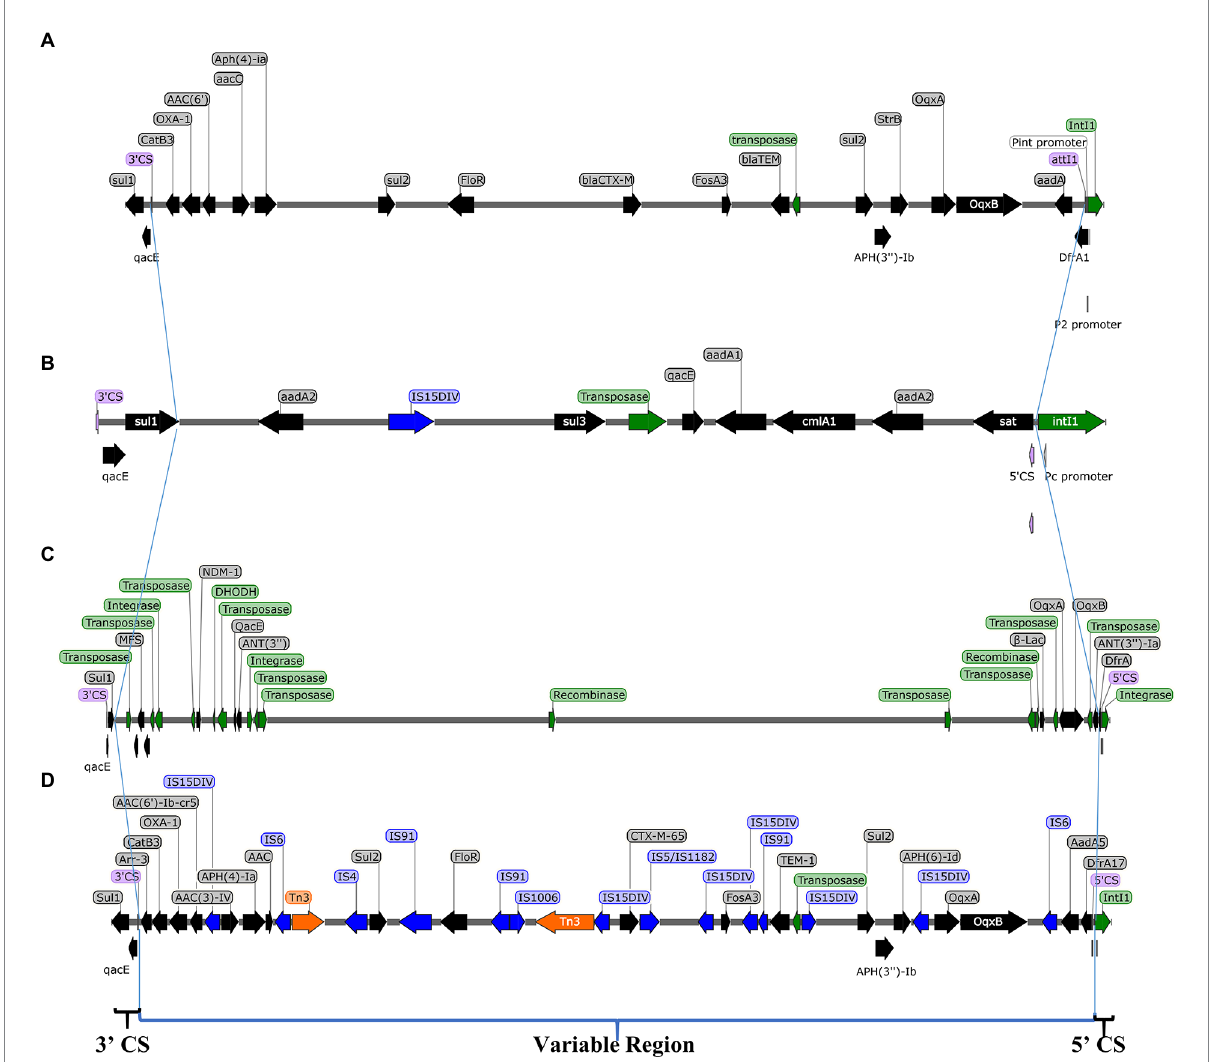
FIGURE 2 Structure of class 1 integron in plasmids of S . Indiana 15 (A) , S . Indiana 222 (B) isolates, S . Indiana C629 (C) , and S . Indiana D90 (D) . ARG, antibiotic resistance genes; IS, insertion sequence; Transposition protein, integrase, and